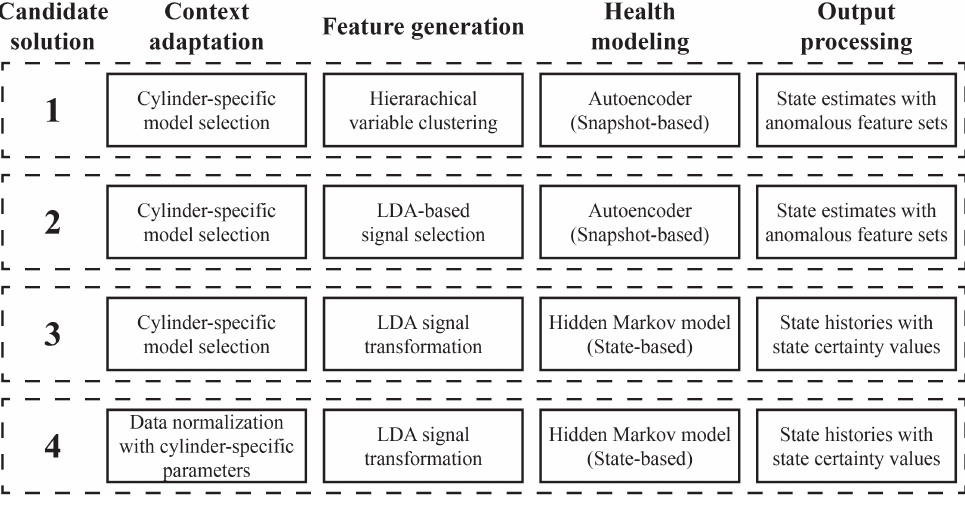
Figure 5. Architectures of four candidate PHM